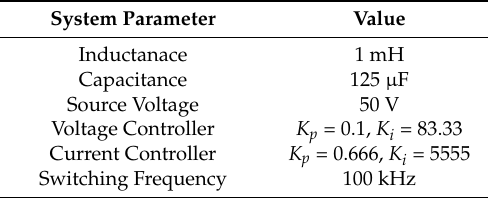
Figure 8. Effect of sensor faults on the control performance. Table 4. System parameters used for sensor failure (Figure 8).